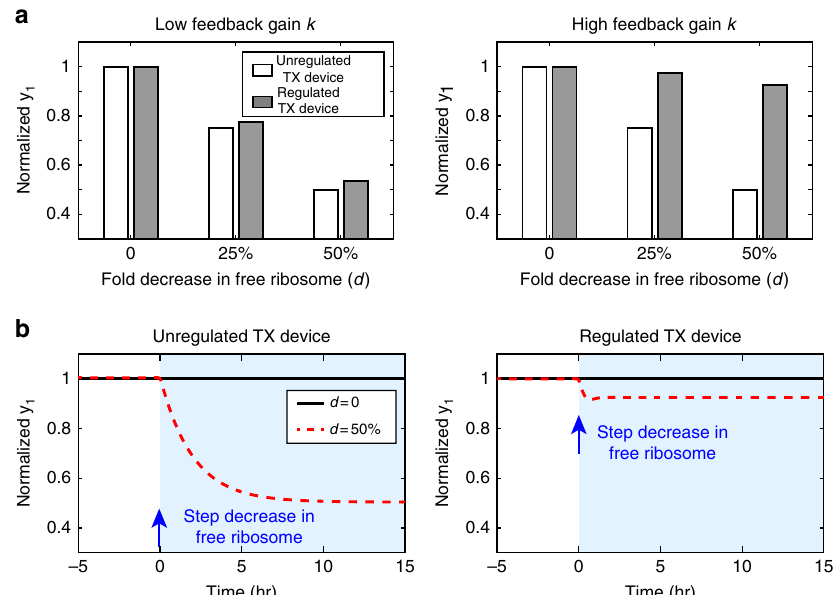
Fig. 3 A regulated TX device with high feedback gain can reach almost perfect adaptation. a Simulation results of the steady states of Eqs. (2) – (4) with different disturbance values d . b Simulation of the temporal response of the GFP output y 1 from the unregulated (circuit in Fig. 2c) and regulated (circuit in Fig. 2a) TX devices. A step decrease in free ribosome concentration is introduced at t = 0 with the value of d indicated in the legend. Simulation parameters are listed in Supplementary Table 9. Source data are provided as a Source Data fi le.Source